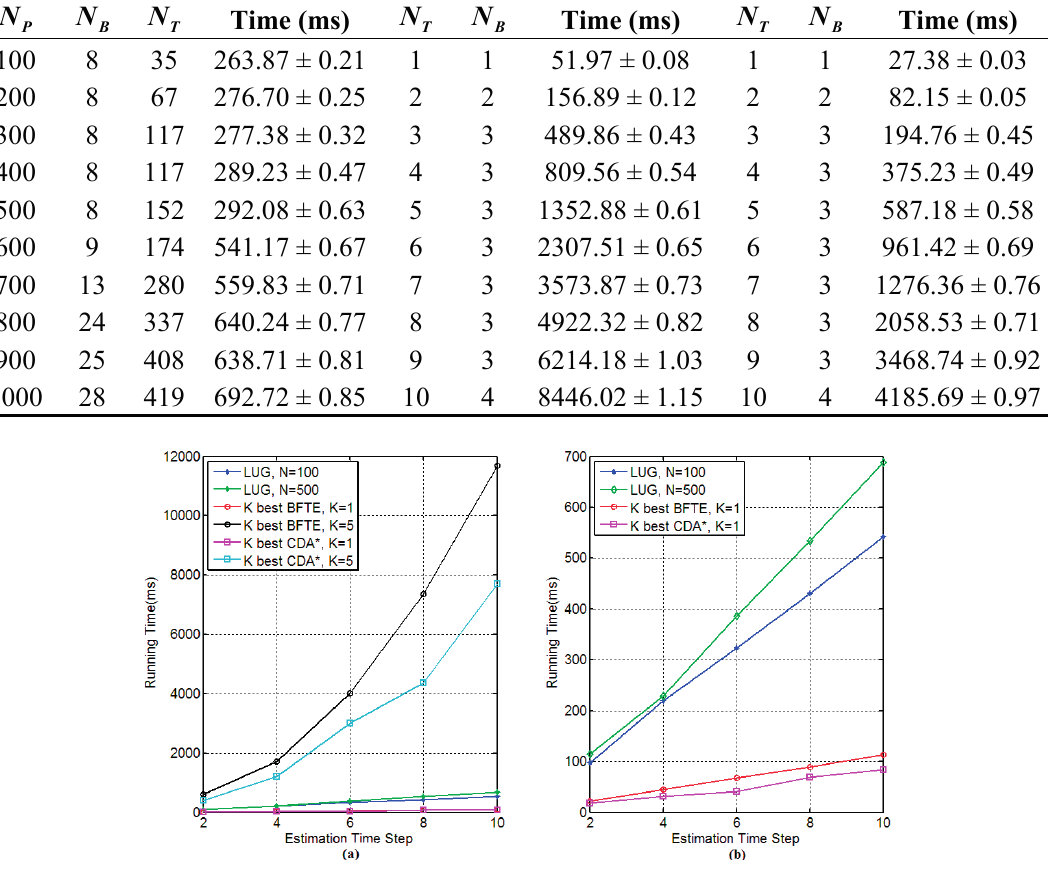
Figure 9. The performance results for different time